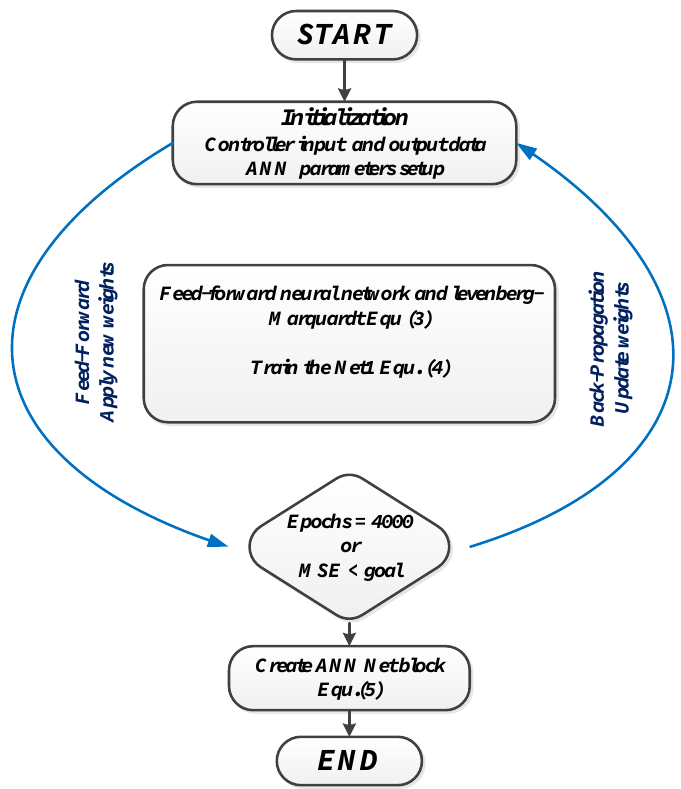
Figure 3. Flow chart of the artificial neural network net training. Table 4. Input parameters (solar data, wind data, energy price, battery SoC, grid power, and fuel level) for 24 h. Time (h) Solar Data (W/m 2